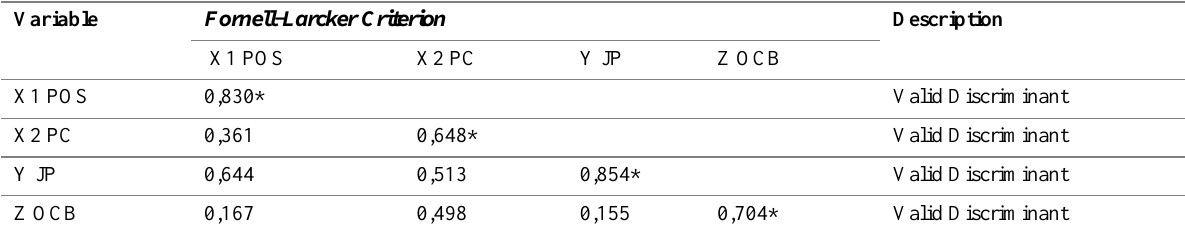
Table 2: Discriminant Validity